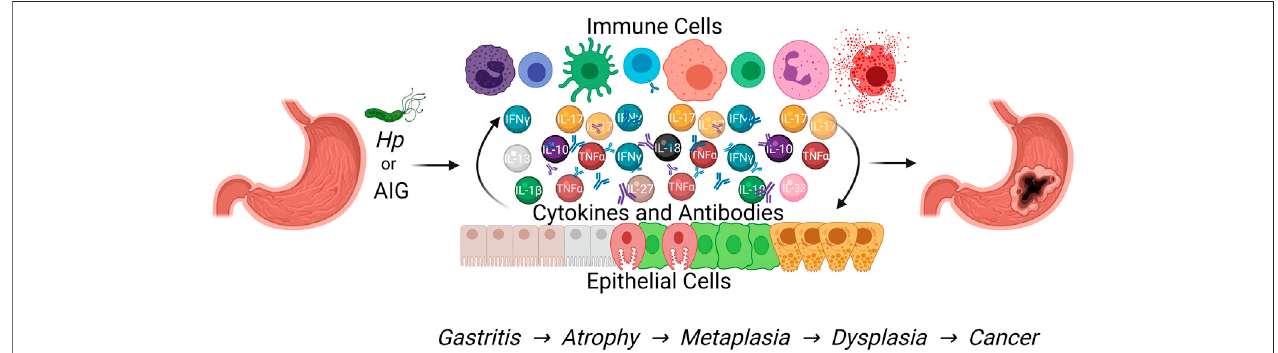
FIGURE 1 | Both Hp infection and autoimmune gastritis causechronic gastric in fl ammation that can progress togastric metaplasia and increasethe risk of gastric adenocarcinoma development. This Figure was created using BioRender.com.